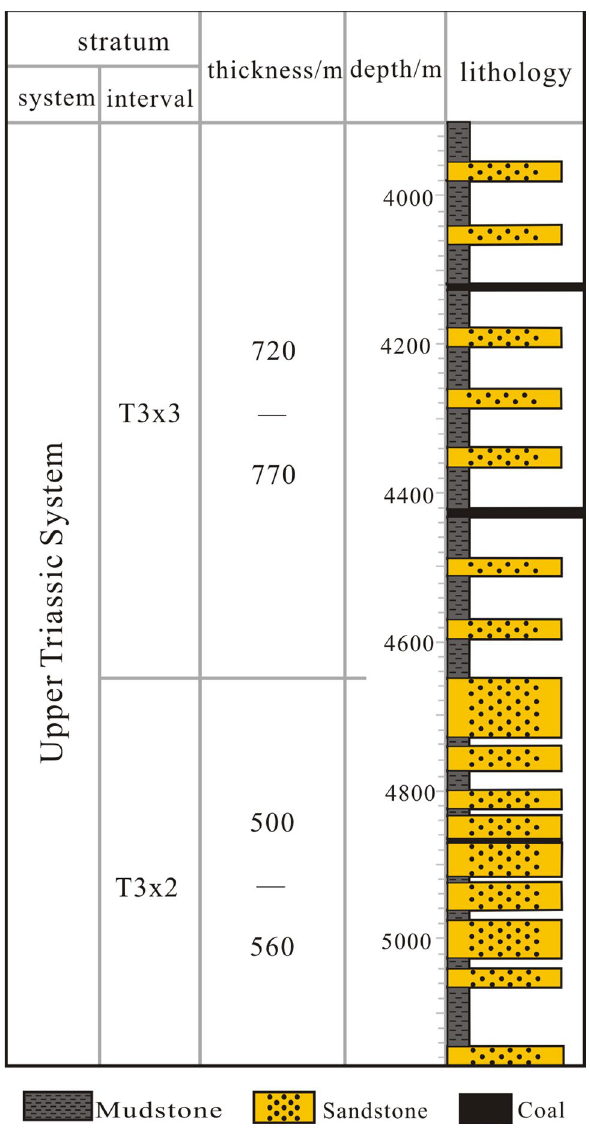
Figure 2. Lithological characteristics of the target layer in the study